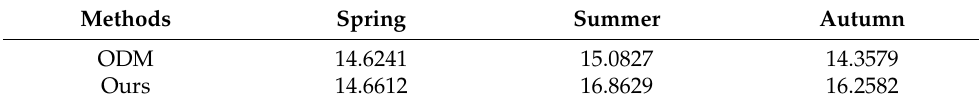
Table 2. PSNR values of two methods on color aerial image mosaic.